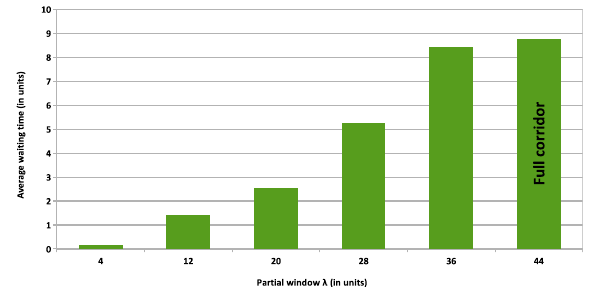
Figure 6. Comparative graph of waiting times for other vehicles with increasing corridor length,